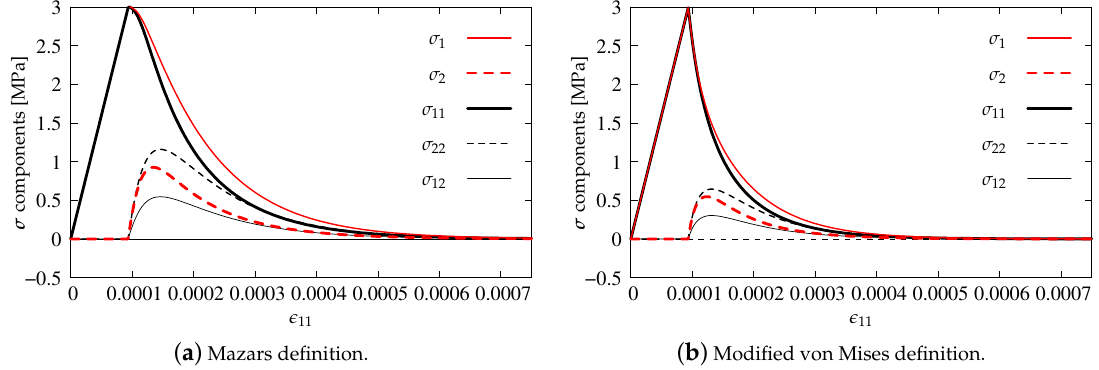
Figure 12. Comparison of stress components for DAP model—pure